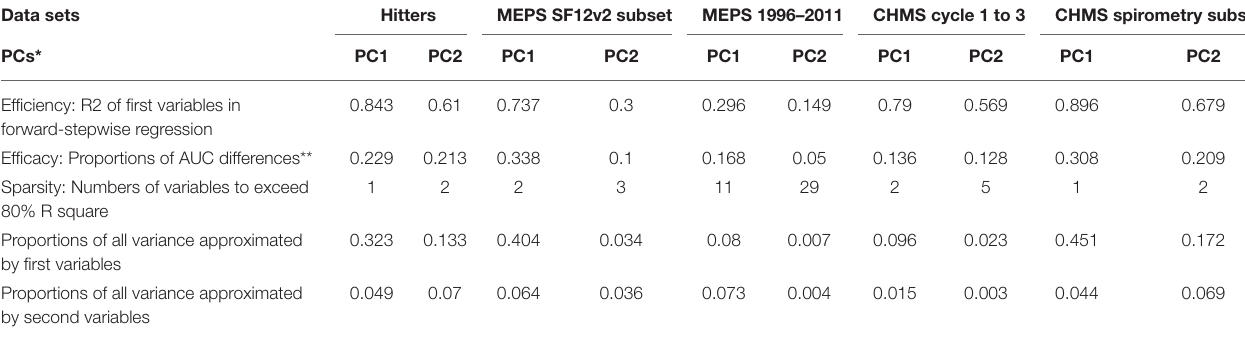
TABLE 2 | Performance of principal component approximation with forward-stepwise regression in the data sets. Data